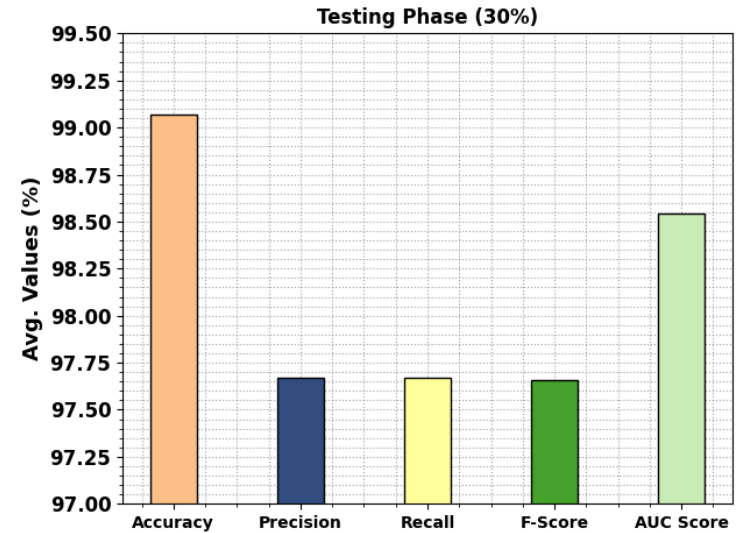
Figure 8. Average outcomes of MPADL-LC3 algorithm on 30% of TSS. The TACY and VACY of the MPADL-LC3 approach are inspected on colon and lung cancer classification performance in Figure 9. The figure signified that the MPADL-LC3 method had improved performance with increased values of TACY and VACY. Visibly, the MPADL-LC3 model attained higher TACY outcomes. The TLOS and VLOS of the MPADL-LC3 technique are tested on colon and lung can- cer classification performance in Figure 10. The figure implied that the MPADL-LC3 model exposed superior performance with minimum values of TLOS and VLOS. Particu- larly, the MPADL-LC3 approach has the fewest VLOS outcomes.